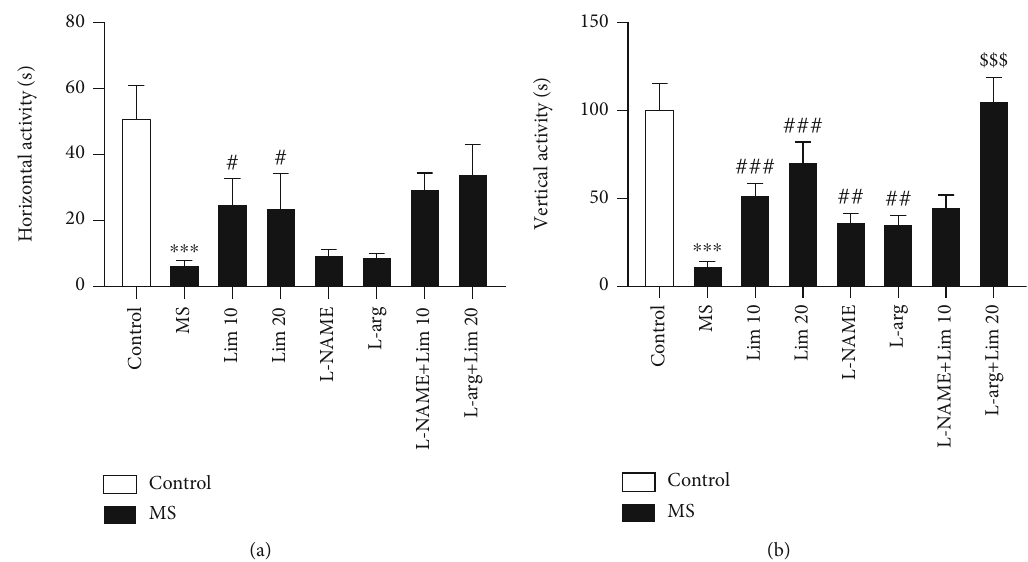
Figure 3: The locomotor activity in the OFT. (a) Horizontal activity and (b) vertical activity. Values are presented as the mean ± S : E : M : from 8 animals and were analyzed by one-way ANOVA followed by Tukey ’ s post hoc test. ∗∗∗ P < 0 : 001 compared to the control group. # P < 0 : 05 , ## P < 0 : 01 , and ### P < 0 : 001 compared to the MS group. $$$ P < 0 : 001 compared to the group that received limonene at a dose of 20 mg/kg. MS: maternal separation; Lim: limonene; L-arg: L-arginine.